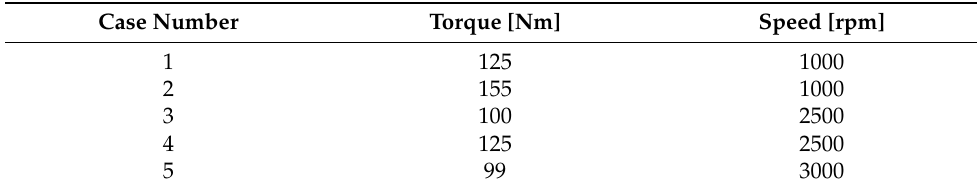
Table 2. Operating points for the experiment.